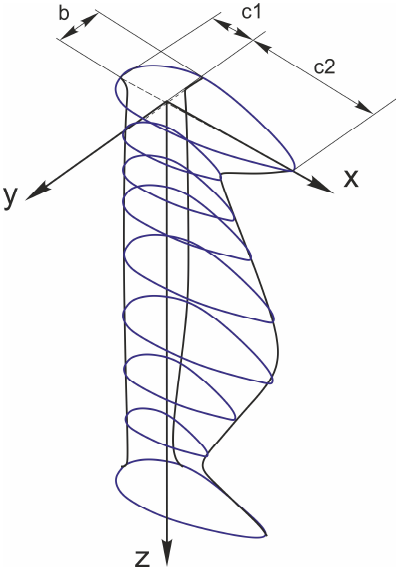
Figure 10. Schematic representation of the weld pool geometry and the parameters of two combined half-ellipses.